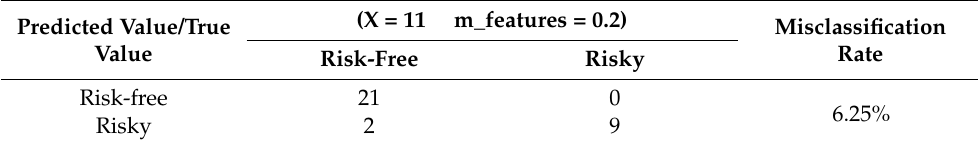
Table 5. Final parameters with the minimum misclassification rate.